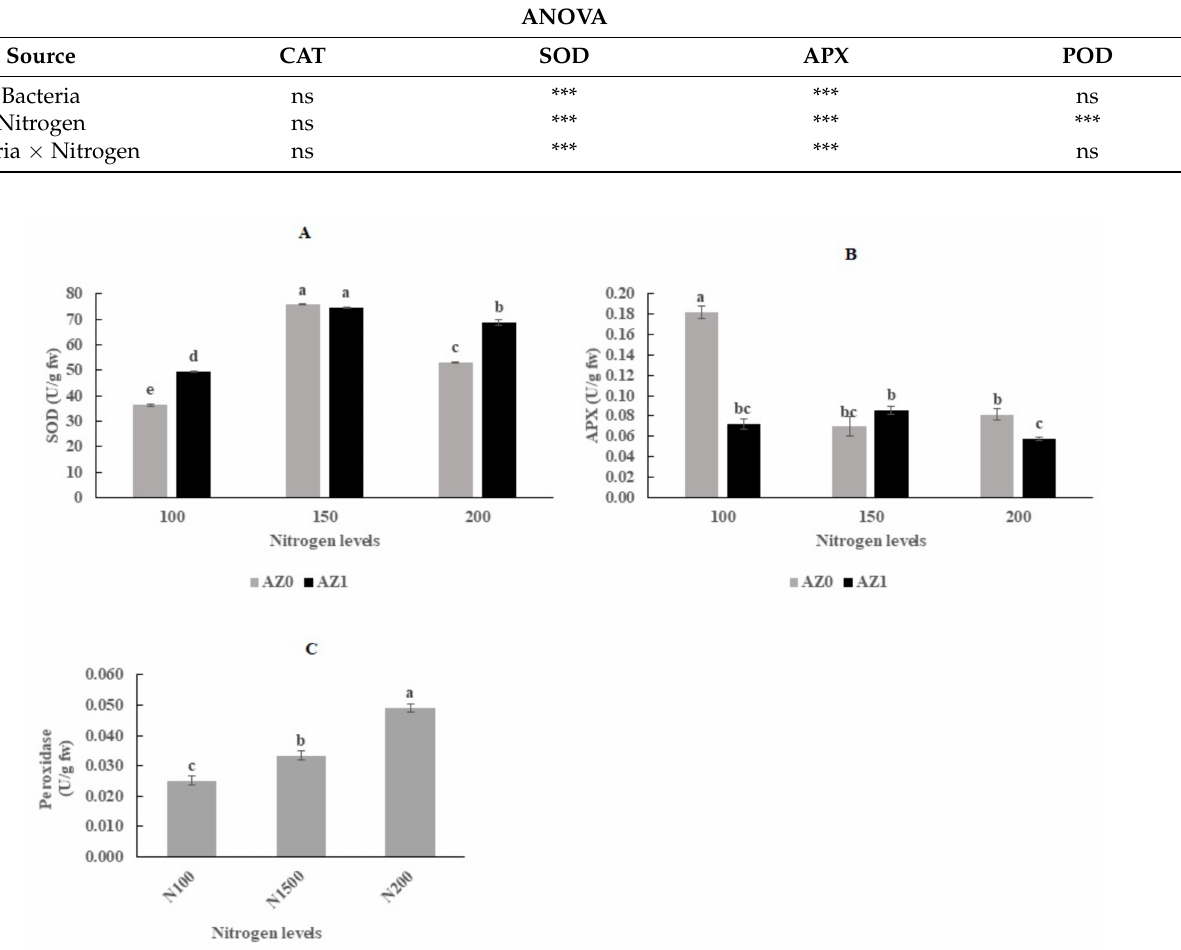
Table 6. Antioxidant enzyme activity (CAT, SOD, APX and POD) in hydroponically grown let- tuce influenced by Azotobacter under different nitrogen levels. The mean comparison using LSD test ( p < 0.05) was implemented for examining the differences among the treatments. Significant differences: *** p < 0.001 and ns: Non-significant.